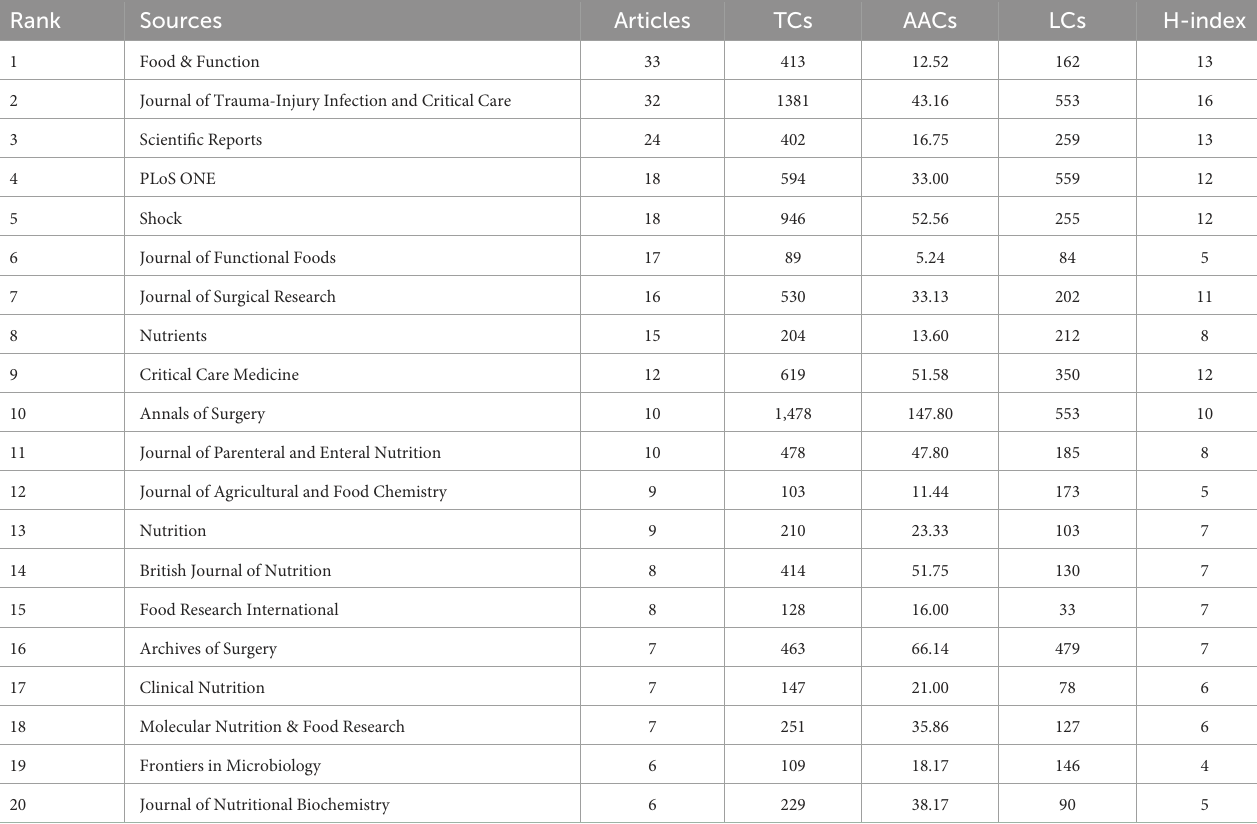
TABLE 2 Top 20 most productive journals for burn and trauma associated with RBPs